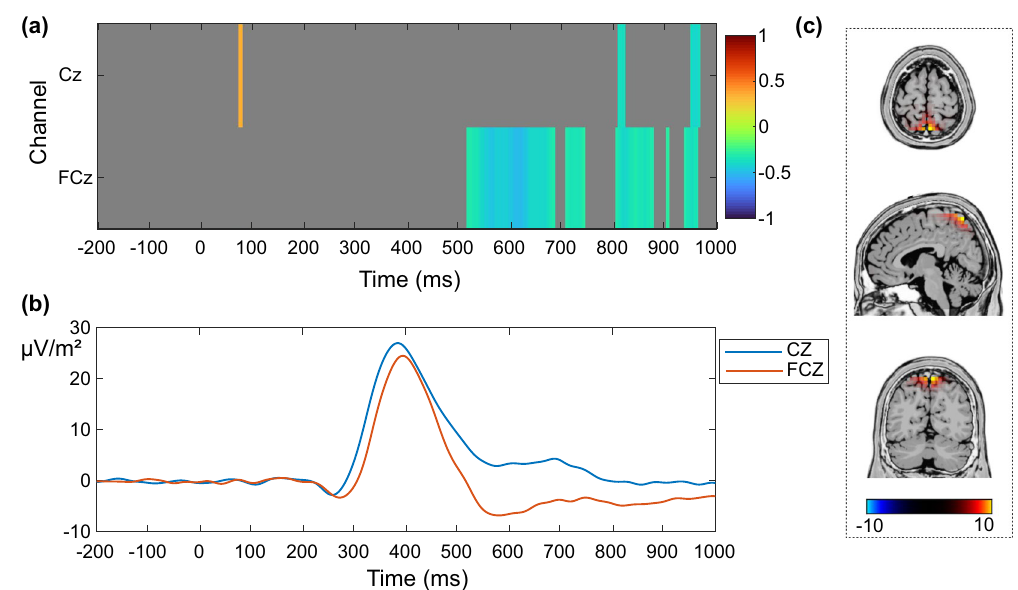
Figure 4. Correlation between resting theta activity and decomposed event-related potentials (ERPs) during correctly rejected Nogo trials in the C-cluster. ( a ) Correlation between resting theta activity and each time point of the EEG signal in the C-cluster from 200 ms before stimulus onset to 1000 ms after stimulus onset for the electrodes Cz and FCz. Only significant correlations with p ≤ .05 after a channel-by-channel correction with the false discovery rate method are shown. The correlation coefficient r is indicated by color. ( b ) Grand average of the participants’ ERPs in the C-cluster for the electrodes Cz (blue) and FCz (orange) from 200 ms before stimulus onset to 1000 ms after the stimulus onset. ( c ) sLORETA plots depicting activation differences in the superior parietal cortex (BA7) after contrasting the Nogo condition (correct rejections) in the C-cluster against zero. The color bar shows the critical t -values ( p < .05, corrected for multiple